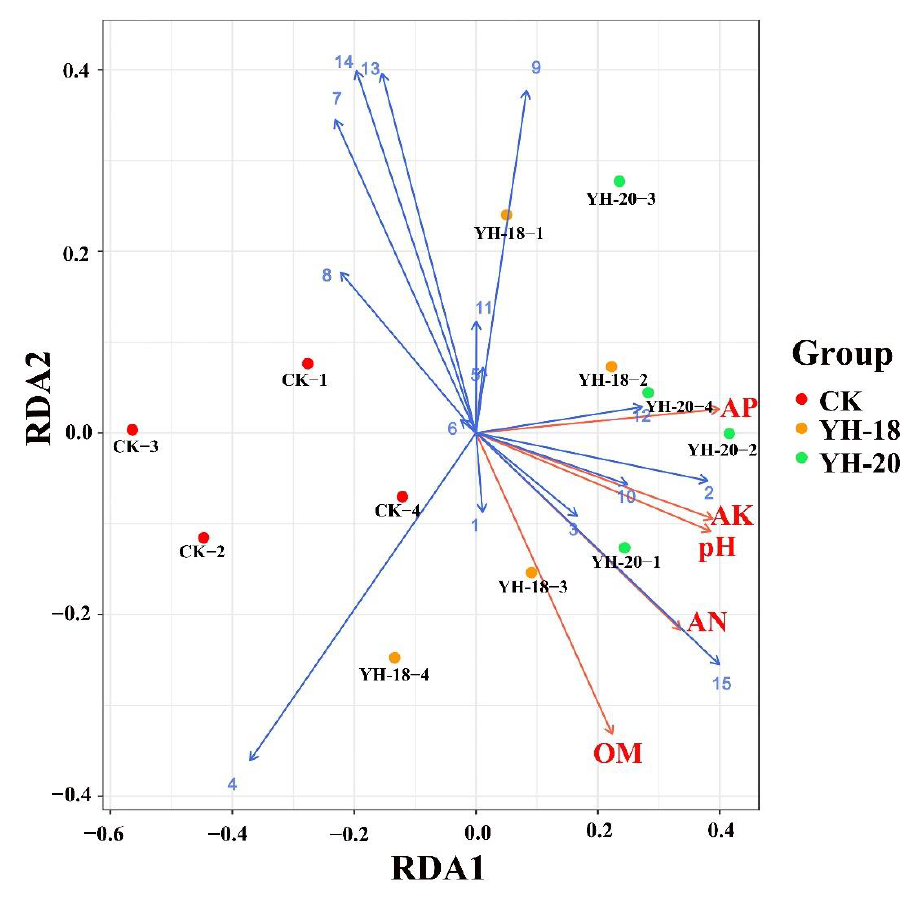
Figure 7. Redundancy analysis of the soil bacterial community composition at the genus level and soil environmental parameters. Soil environmental parameters are represented by red lines and bacterial genera are represented by blue lines (1: Sphingomonas , 2: Pseudomonas , 3: Flavobacterium , 4: RB41 , 5: Dongia , 6: Gemmatimonas , 7: Haliangium , 8: MND1 , 9: Acidibacter , 10: Arenimonas , 11: Bryobacter